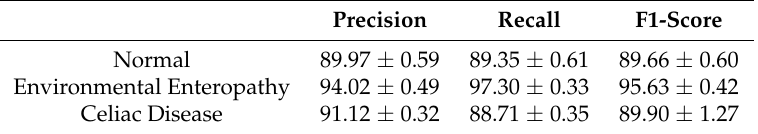
Table 3. Result of parent level classifications for normal, environmental enteropathy, and Celiac disease.